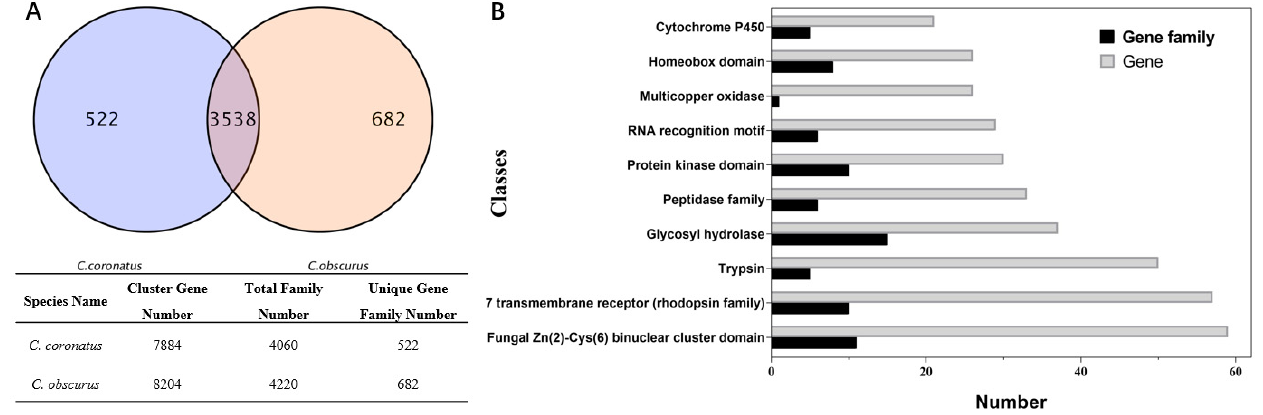
Figure 6. The comparative genomic analysis of C. obscurus and C. coronatus using OrthoMCL. ( A ) The common and unique gene family ( B ) The top 10 Pfam-annotated unique genes in the C. obscurus genome.